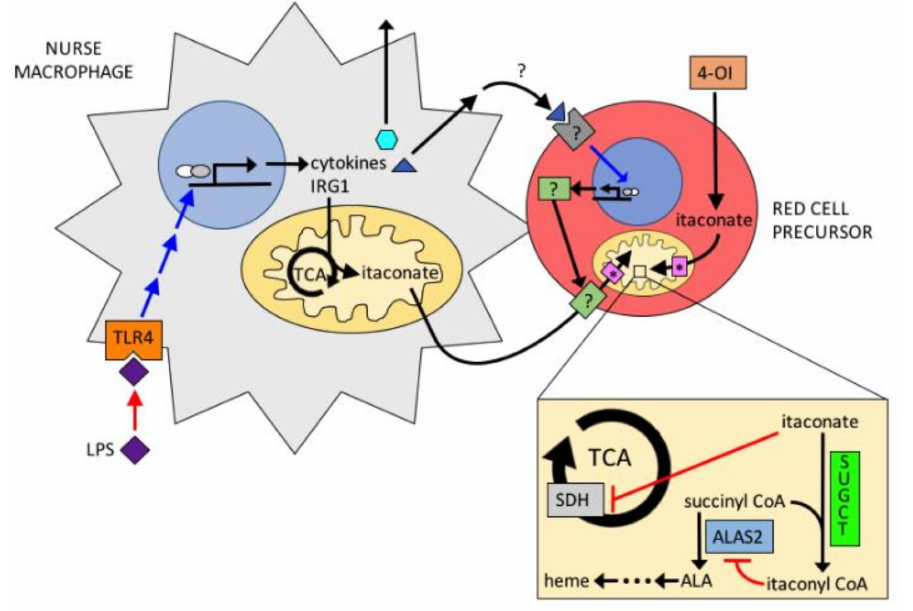
Figure 6. Proposed model for the action of itaconate in erythropoiesis. Itaconate is produced by nurse macrophages via LPS stimulation. Itaconate is imported into erythroid precursors and converted to itaconyl-CoA by SUGCT. Itaconyl-CoA inhibits ALAS2 and